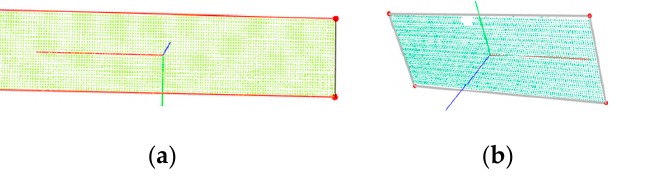
Figure 3. Corner detection result. ( a ) Corner points based on AABB; ( b ) corner points based on OBB.